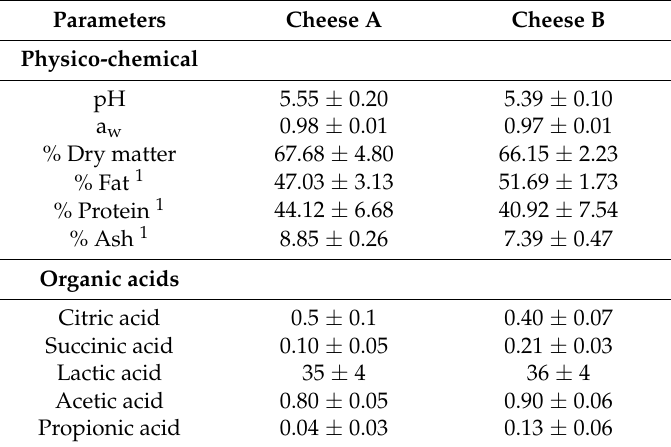
Table 2. Physico-chemical characteristics and organic acids content (mg/g) in cheeses at the end of ripening. Parameters Cheese A Cheese B Physico-chemical